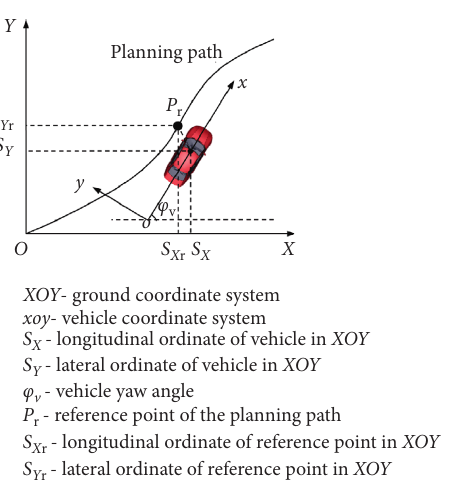
Figure 3: Plane movement of vehicle lane-change on curved